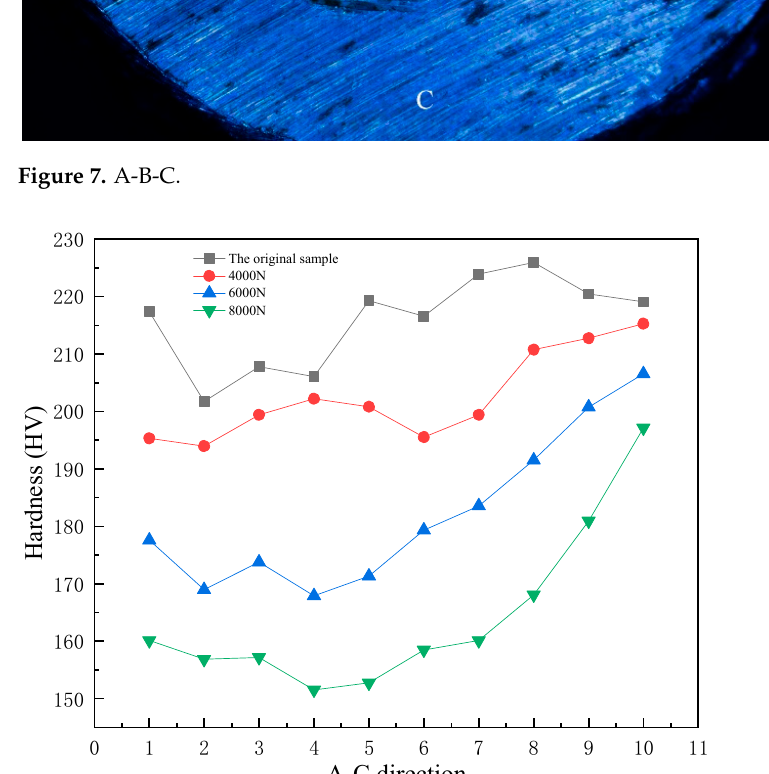
Figure 8. A–C hardness change. Figure 8. A-C hardness